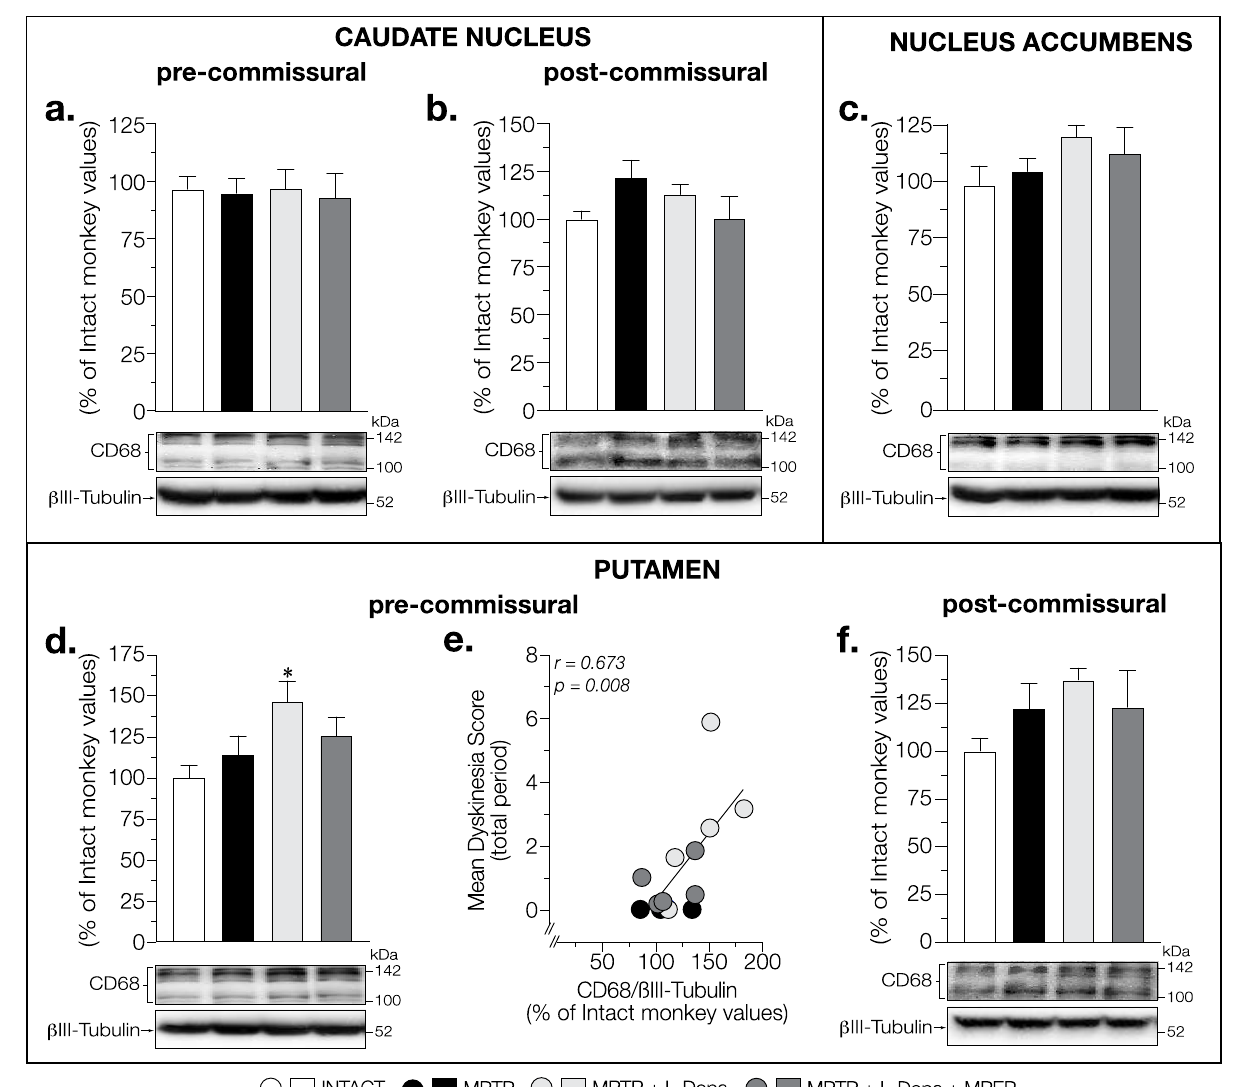
Figure 9. Western blots for CD68 protein levels in ( a , b ) the pre- and post-commissural caudate nucleus, ( c ) nucleus accumbens, and in ( d , f ) the pre- and post-commissural putamen, of intact monkeys (control), MPTP monkeys treated with saline, L-Dopa, and L-Dopa + MPEP, and correlation between mean dyskinesia score of MPTP monkeys treated with saline, L-Dopa, and L-Dopa + MPEP, and CD68 levels in ( e ) pre-commissural putamen expressed as percentage of control ( β III-tubulin was used as internal loading control); each point represents an individual monkey. Values are means of arbitrary units expressed as percentage of control (βIII -tubulin was used as internal loading control) of 2 – 4 independent experiments ± standard error of mean of 4 – 5 monkeys per group. * p < 0.05 vs. INTACT.